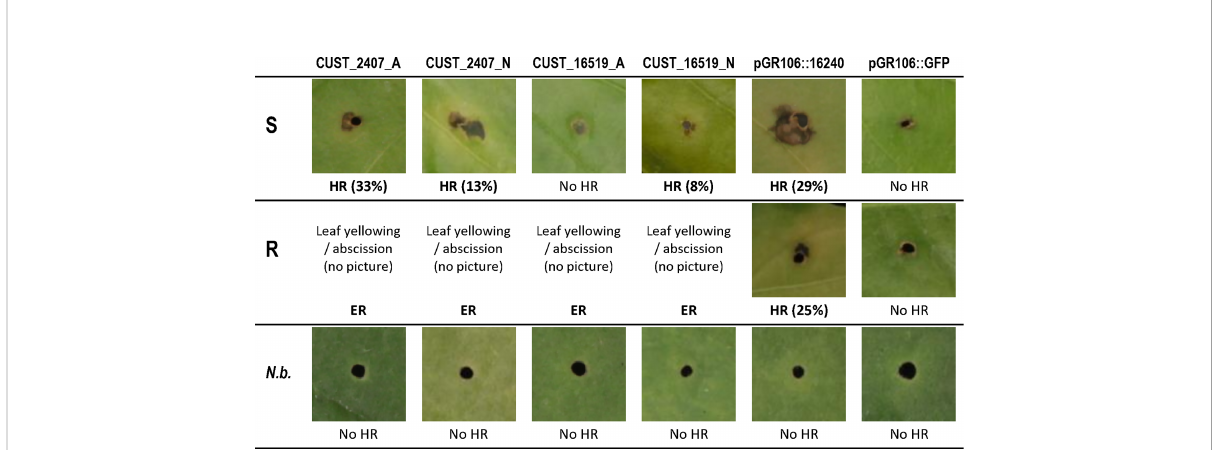
FIGURE 7 Symptoms of transient in planta expression of RxLR genes CUST_2407 and CUST_16519 from isolates A and N in leaves of pepper hosts R and S after PVX agro-infection. Dark local necrosis around the agro-infection points was scored as a hypersensitive response (HR). With constructs CUST_2407 and CUST_16519 from isolates A and N, host R showed yellowing followed by abscission of agro-infected leaves, which were assumed to correspond to extreme resistance (ER). In parentheses are indicated the percentages of 24 agro-infected points which showed a HR. The constructs pGR106::16240 and pGR106::GFP were used as positive and negative controls, respectively. Leaves of Nicotiana benthamiana ( N.b. ) do not show dark local necrosis with the six agro-infected constructs. Photographs were taken at 15 to 20 days after